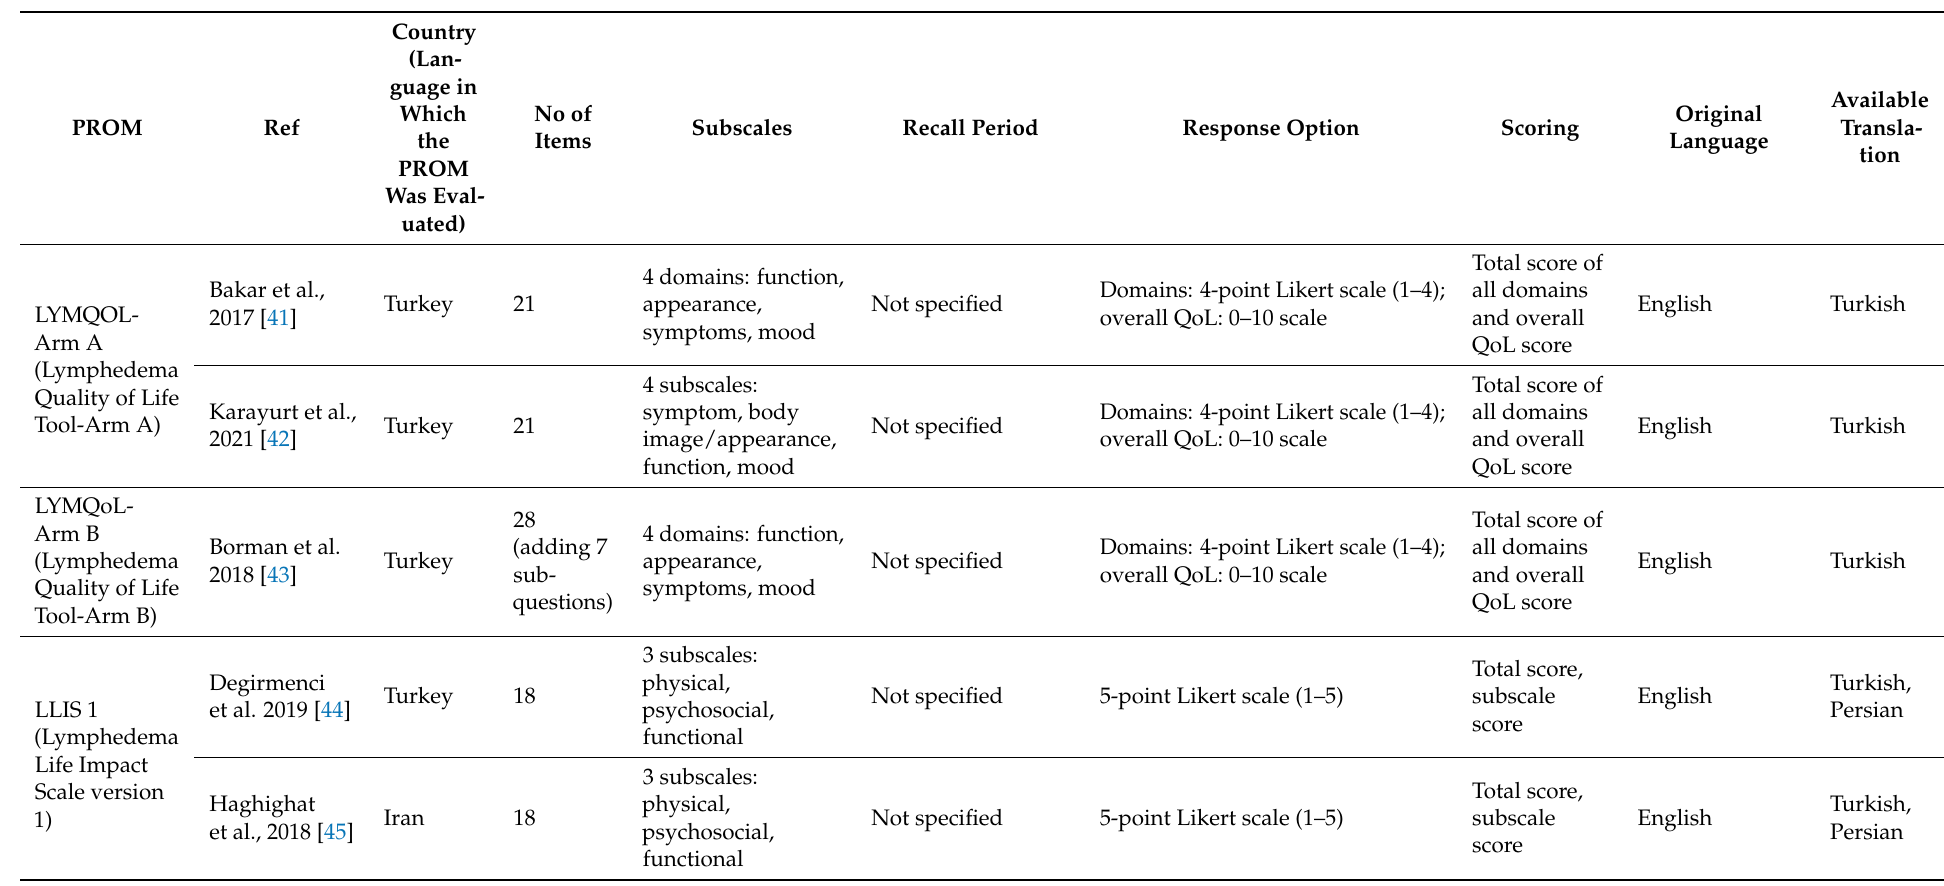
Table 4. Characteristics of included